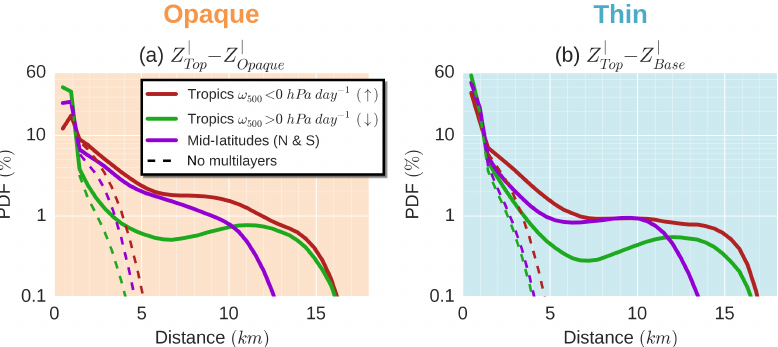
| opaque among opaque clouds and (b) the distance between cloud top